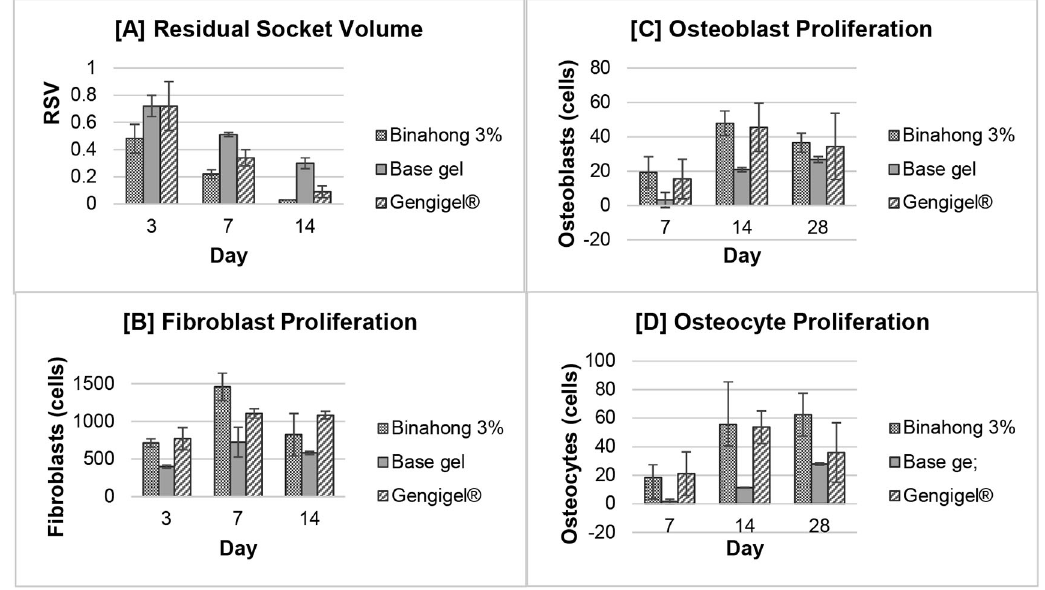
Figure 3. Clinical and histopathological analysis of alveolar bone healing between different treatment groups. Results were shown as the means of the residual socket volume (clinical observation) and the number of fibroblast, osteoblast, and osteocyte cells (histopathological